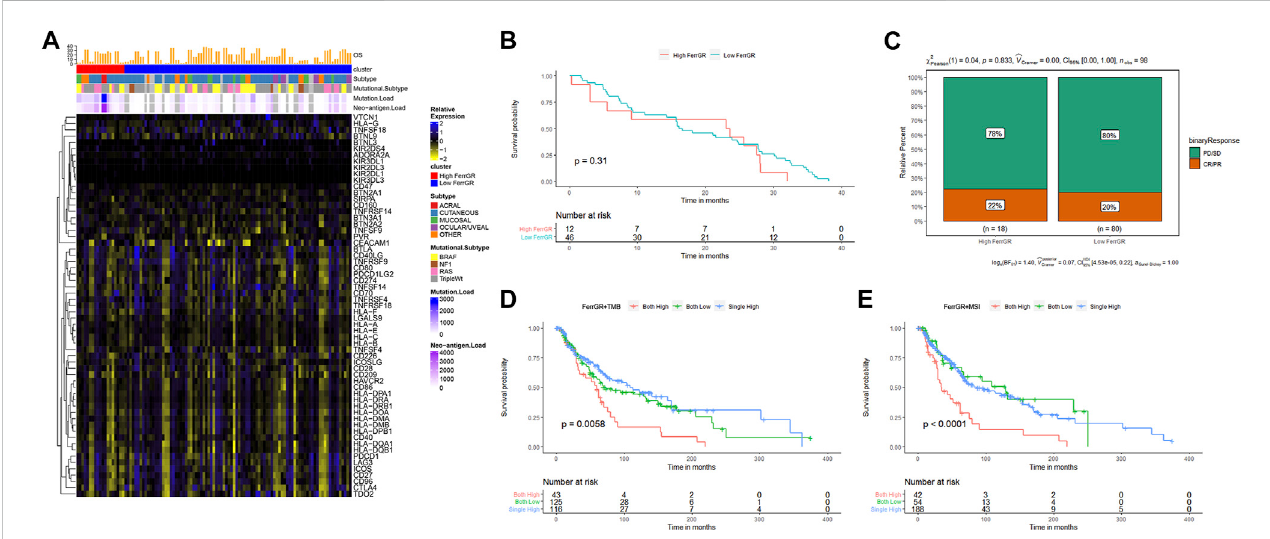
FIGURE 6 EvaluationofimmunotherapyinSKCMwithFerrGRmodel. (A) Heatmapdisplayingtheexpressionlevelsof61immunecheckpointgenesinthehighFerrGRgroup andlowFerrGRgroup. (B) Kaplan-Meiercurvesofthehigh-FerrGRandlow-FerrGRgrouppatientsintheGSE91061dataset. (C) Theproportionofimmuneresponseto immunotherapy of high- and low-FerrGR groups in the TCGA cohort. CR, complete response; PR, partial response; SD, stable disease; PD, progressive disease. (D) Kaplan- Meier survival analysis of OS among patients withineach of the three indicated subgroups (Both high: FerrGR-high/TMB -high; Both low: FerrGR-low/ TMB-low; Single high: FerrGR-high/TMB-low or FerrGR-low/TMB-high). (E) Kaplan-Meier survival analysis of OS among patients within each of the three indicated subgroups (Both high: FerrGR-high/MSI -high; Both low: FerrGR-low/MSI-low; Single high: FerrGR-high or